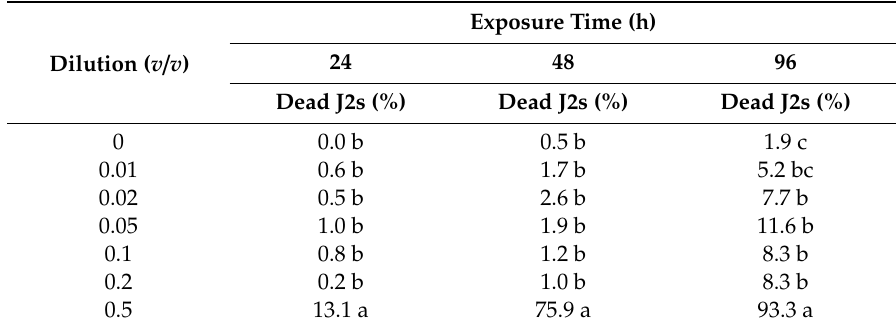
Table 4. E ff ect of hydrosol on the motility of M. incognita J2s after immersion in test solutions at the